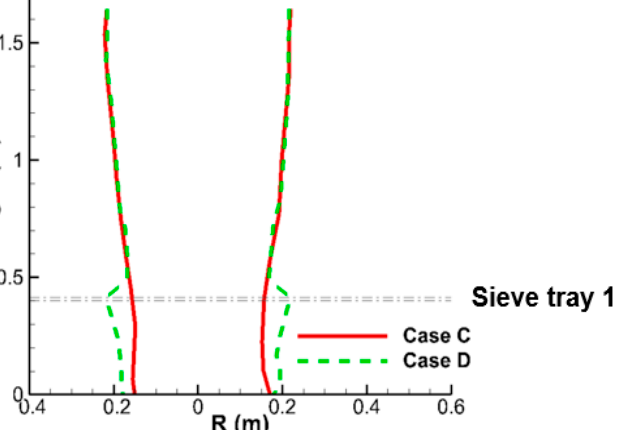
Figure 16. This schematic shows the radius of liquid column of the small-scale tower for Case C and D. Correspondingly, the high SO 2 region near the wall of tower is reduced significantly from Case C to Case D, as shown in Figure 15c at y = 0.615 m. The stronger two-phase mixing near the sieve tray and smaller region of high SO 2 near the wall lead to a higher SO 2 removal efficiency for Case D (61.6%) than Case C (56.9%) in Table 6. In comparison